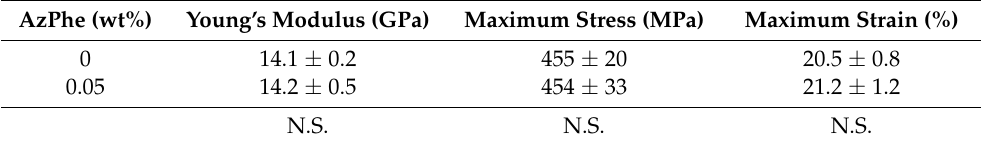
Table 2. Mechanical properties of raw silk fiber reeled from the cocoons of the F 1 hybrid, H06 × (Nichi509 × Nichi510), reared on a normal or an AzPhe-containing diet. All values in this table are the average of three independent experiments with standard deviations ( n = 3). In each experiment, 50 threads were tested and their results were averaged. Statistical significance by t-test is shown in the bottom column. AzPhe (wt%) Young’s Modulus (GPa) Maximum Stress (MPa) Maximum Strain (%) 0 14.1 ± 0.2 455 ± 20 20.5 ± 0.8 0.05 14.2 ± 0.5